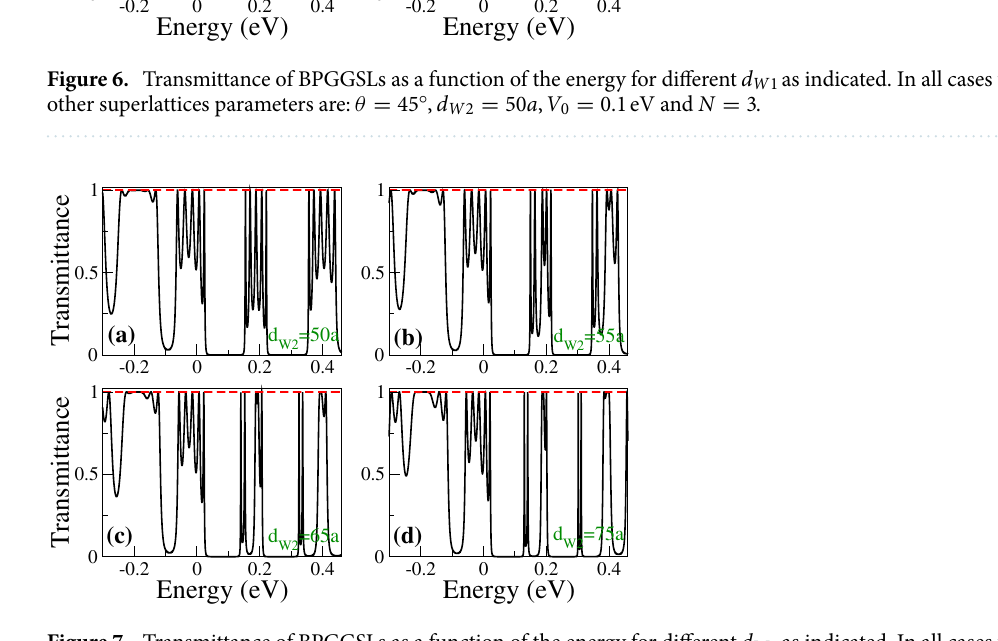
Figure 7. Transmittance of BPGGSLs as a function of the energy for different d W 1 as indicated. In all cases the other superlattices parameters are: θ = 45 ◦ , d W 2 = 50 a , V 0 = 0.1 eV and N = 3